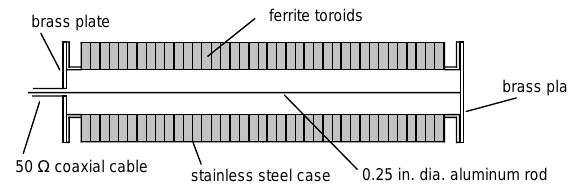
FIG. 6. Schematic cross section of the measurement setup with test